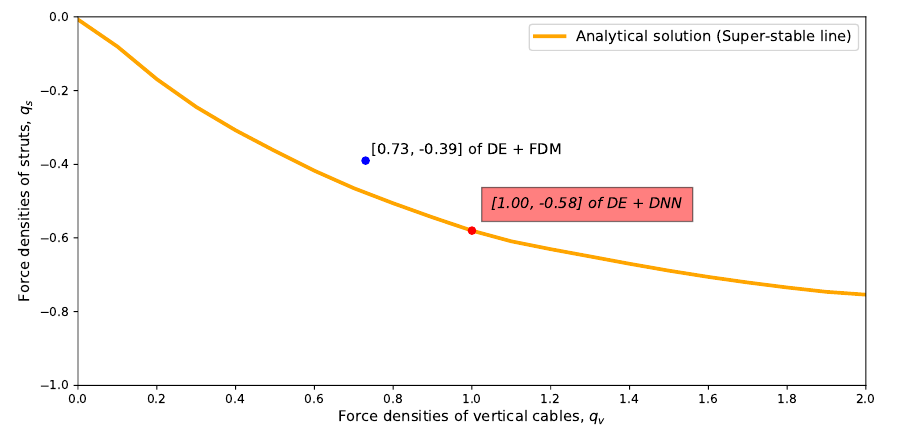
Figure 12. Comparison of the force densities of the 3D truncated tetrahedron tensegrity using an FDM, a DNN-based form-finding model with a DE algorithm and a analytical solution [6].